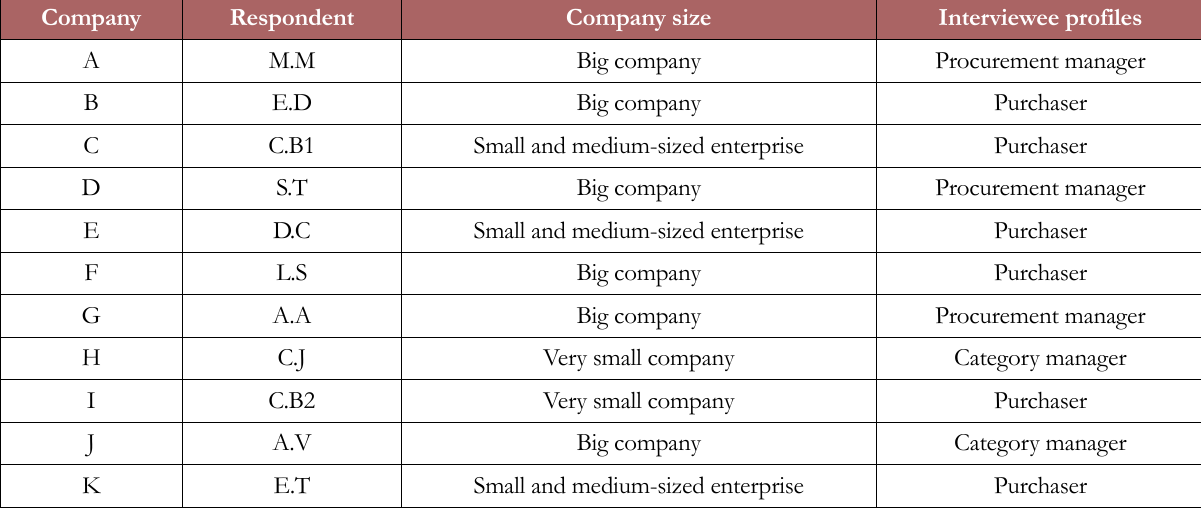
Table 5. List of